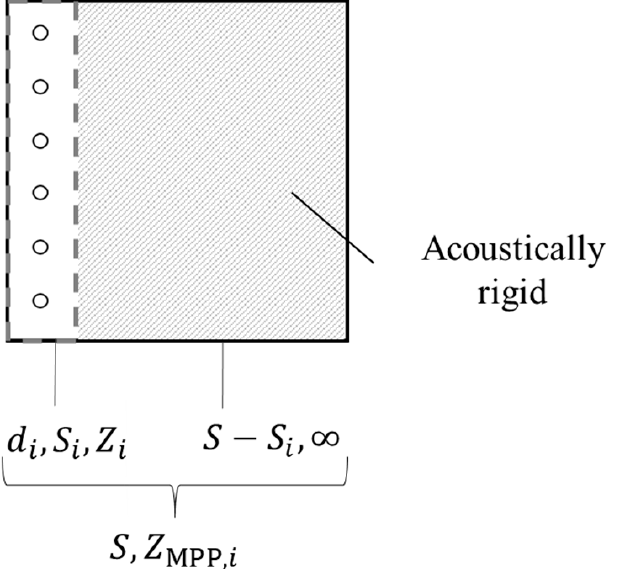
Figure 2. A diagram of the calculation procedure for the impedance of a hypothetical MPP. The area surrounded by the dashed line is the part with holes, and the hatched area is the part without holes, which is acoustically rigid.